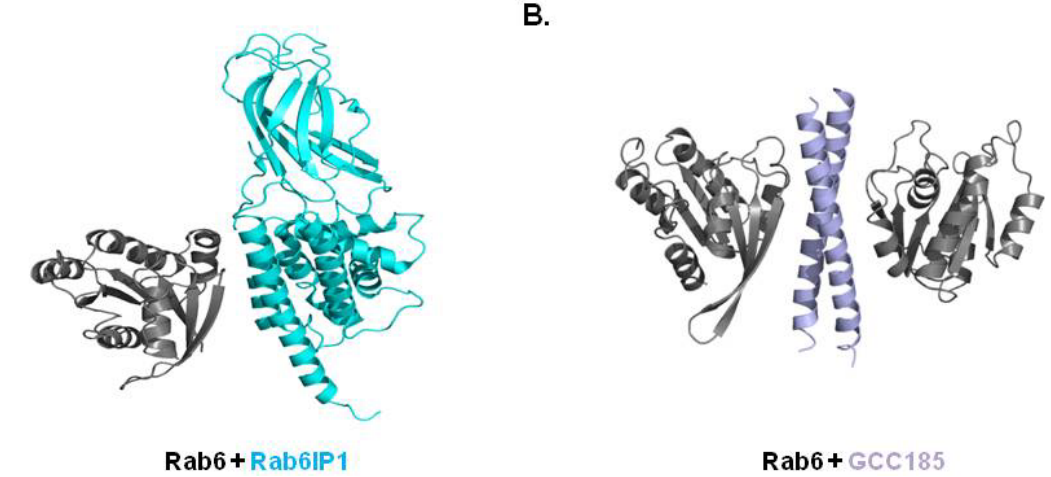
Figure 4. ( A ) Crystal structure of the Rab6/Rab6IP1 complex (PDB ID: 3CWZ)—The representative Rab6/effector complex structure; ( B ) Crystal structure of Rab6/GCC185 complex (PDB ID: 3BBP)—The additional 2:2 complex structure of the